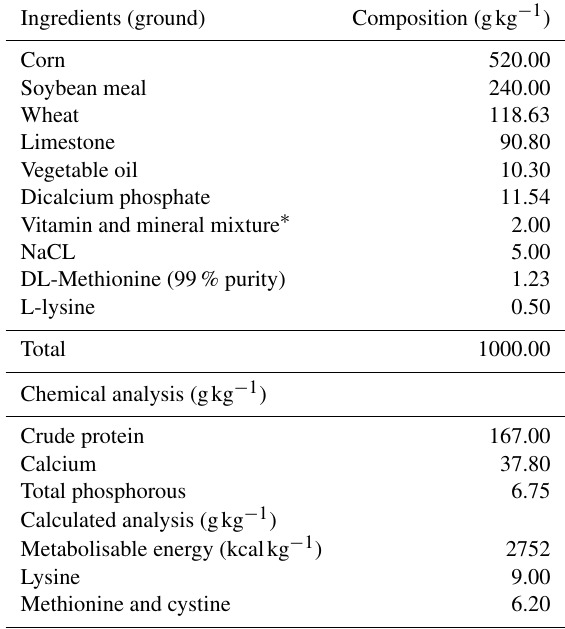
Table 2. Composition of basal